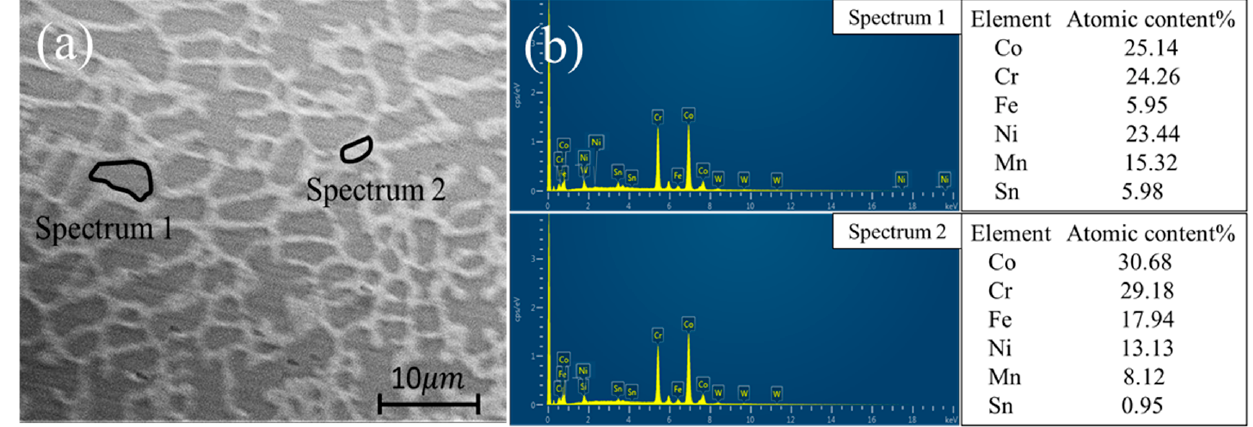
Figure 7. EDS scanning area ( a ) and corresponding energy spectrum ( b ) of Sn 0.2 alloy coating.